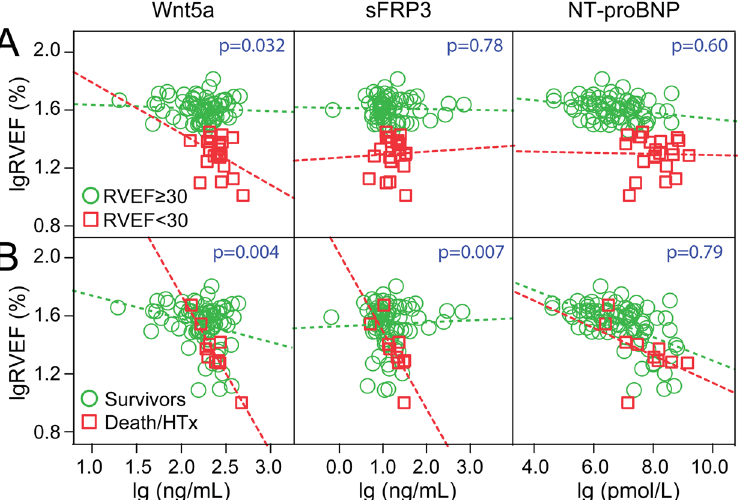
Figure 2. Interactions between Wnt5a and sFRP3 levels and indices of ventricular function. Interaction analysis between Wnt5a, sFRP3, NT-proBNP and RVEF ( A ) in patients with impaired RV function (i.e. RVEF < 30%, n = 22) and ( B ) in patients with adverse outcome (n = 13). Interaction analysis was performed including covariate (e.g. Wnt5a), fixed factor (e.g. RVEF with cut-off) and their interaction term. The p-value of the interaction term is shown in blue. HTx, heart transplantation; NT-proBNP, N-terminal pro-brain natriuretic peptide; RVEF, right ventricular ejection fraction; sFRP3, secreted frizzled-related protein